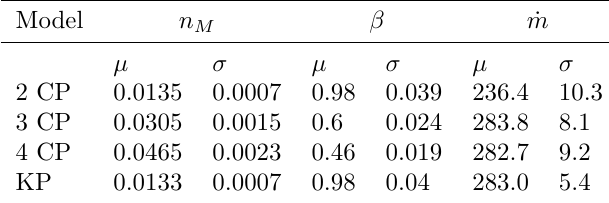
Table 1: Details of input parameters and output flow rate for different models